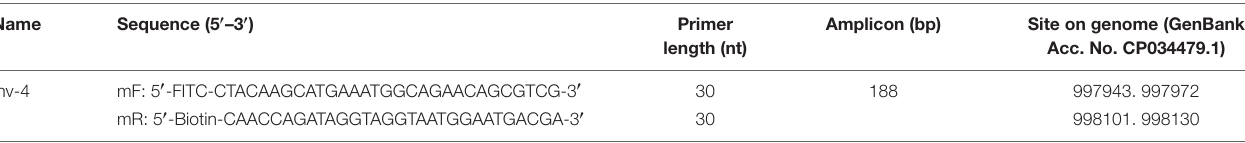
TABLE 2 | Modification of primer pair Inv-4 with chemical